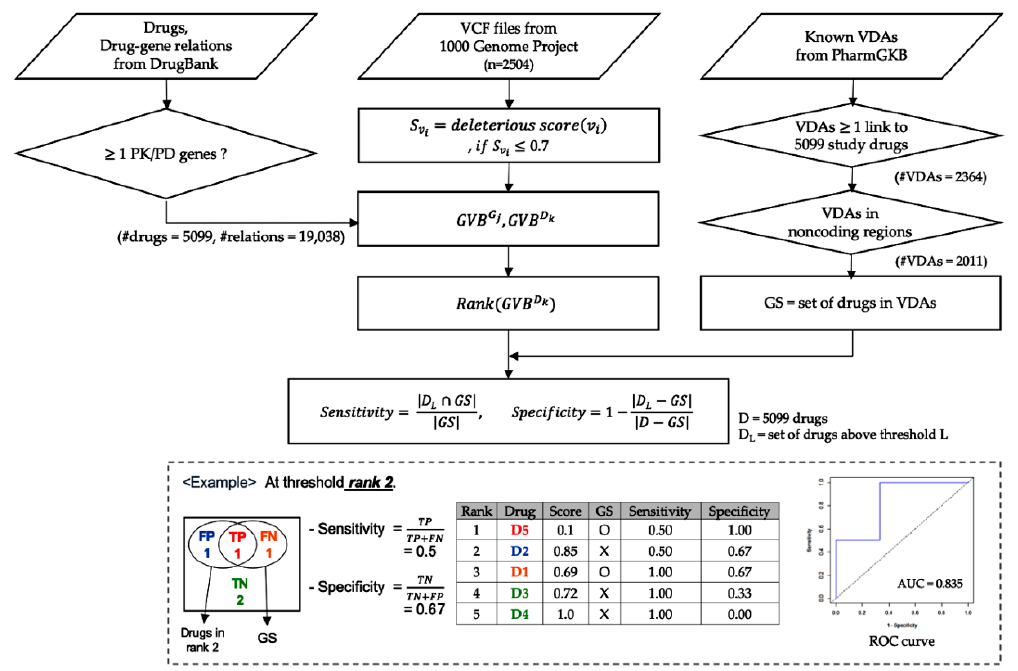
Figure 1. Workflow of the study. This workflow shows the steps for calculating the gene and drug GVB and evaluating scores by testing the presence or absence of the known VDAs in the PharmGKB. Abbreviations: VDA, variant-drug associations; PK, pharmacokinetics; PD, pharmacodynamics; GVB, gene-wise variant burden; AUC, area under the receiver operating characteristics curve; ROC, receiver operating characteristic; TP, true-positive (red); TN, true-negative (green); FP, false-positive (blue); FN, false-negative (orange); and GS, gold standard.